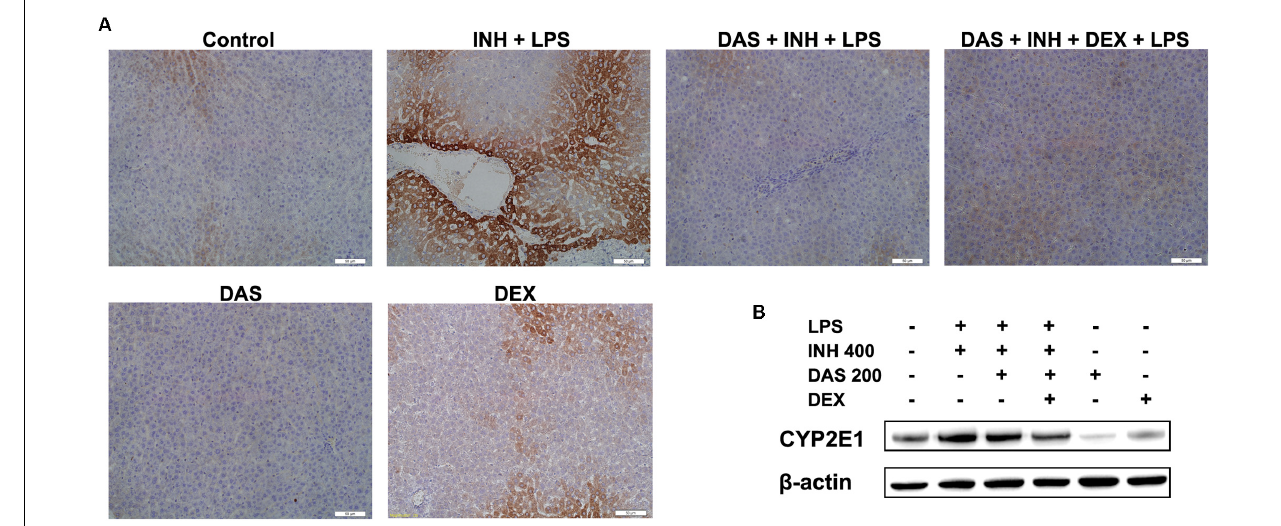
FIGURE 6 | Hepatic CYP2E1 protein expression levels following drugs administration. (A) INH/LPS treatment elevated CYP2E1 expression (deep brown color). Moreover, DAS-only administration to the animals received INH/LPS marginally reduced CYP2E1 expression, but addition of DEX to the combination significantly inhibited CYP2E1 protein expression probably through elimination of LPS-enhancing effects, as indicated by the fading color. (B) CYP2E1 immunoblotting analysis, β -actin used as internal control.